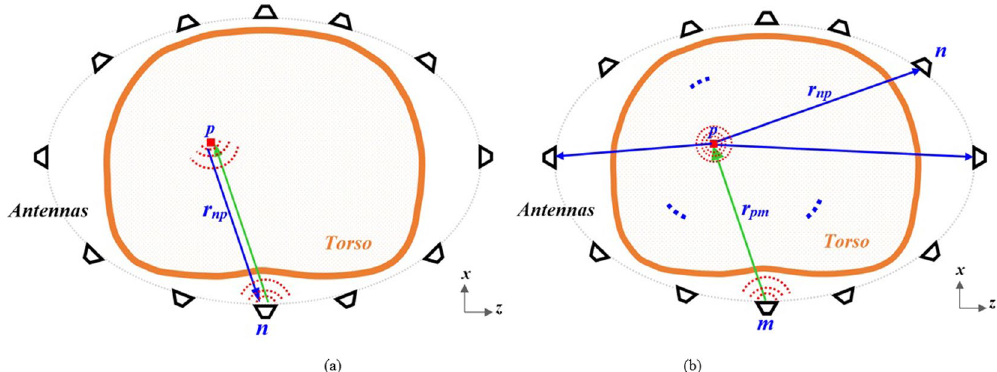
Figure 4. Scattering signal acqusition in ( a ) mono static and ( b ) multistatic